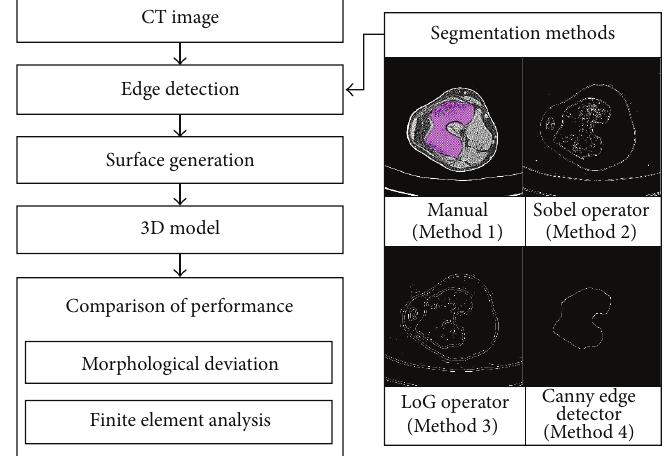
Figure 5: Experimental procedure.